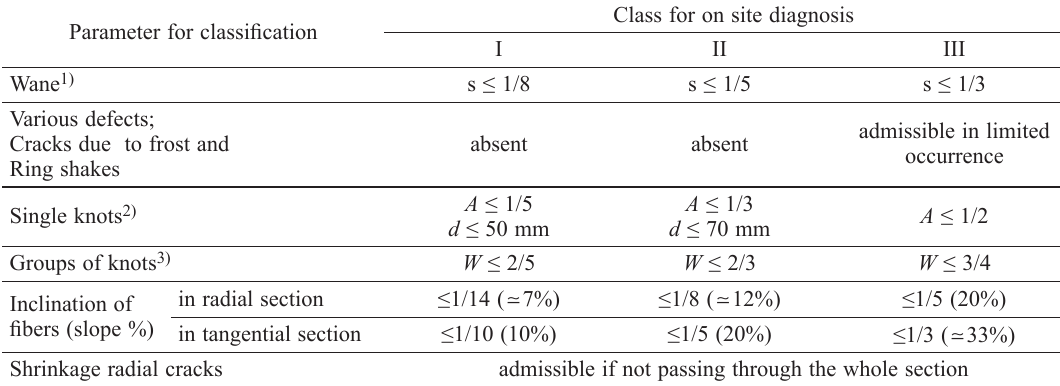
Table 1. Grading rules for structural elements in an onsite diagnosis (UNI 11119:2004) Parameter for